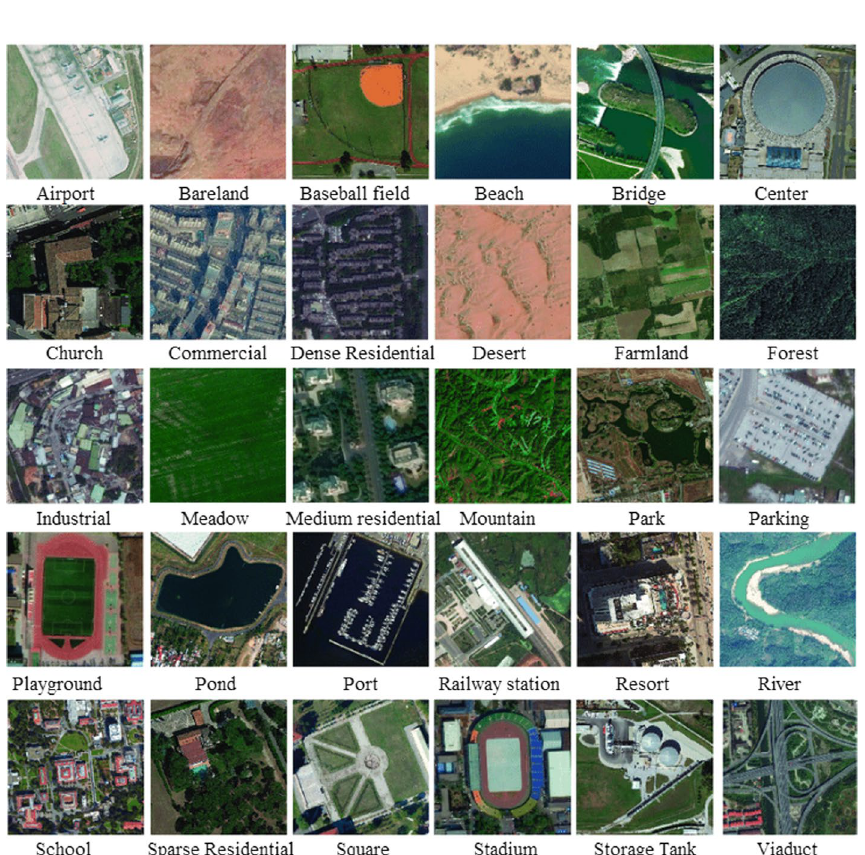
Fig. 6 Samples of AID